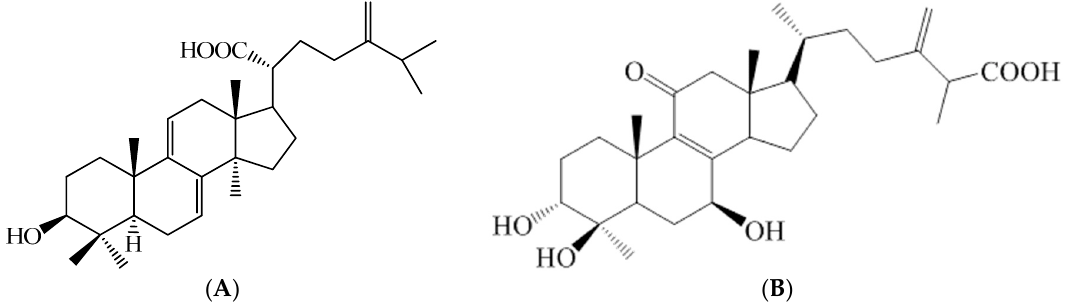
Figure 1. Chemical structures of ( A ) dehydroeburicoic acid (TT) and ( B ) antcin K